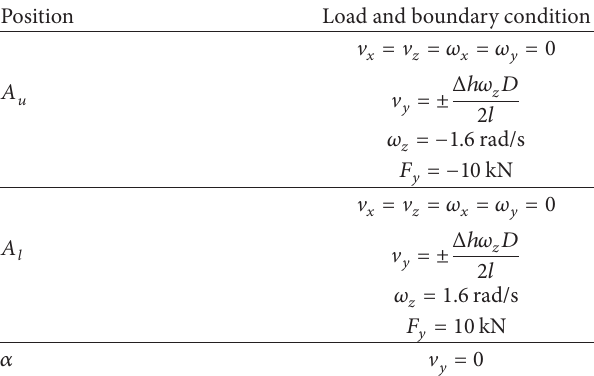
Table 3: Loads and boundary conditions for phase